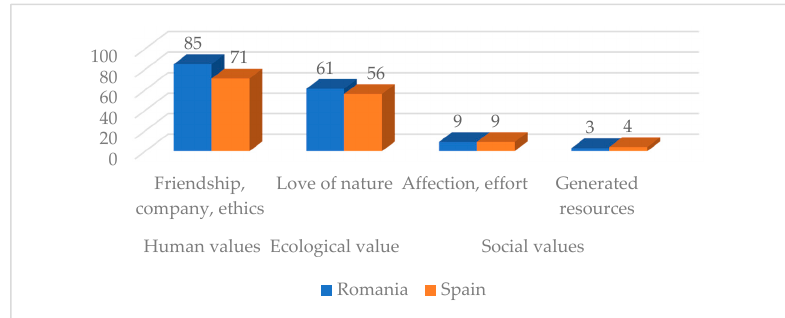
Figure 5. Hunting values.